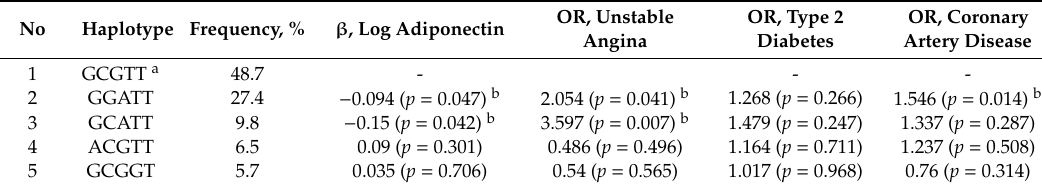
Table 6. Associations of constructed haplotypes with logarithm of serum adiponectin concentration, unstable angina, type 2 diabetes, and coronary artery disease. Haplotypes were constructed using five sequential SNPs of the ADIPOQ gene in the following order: rs17300539, rs266729, rs182052, rs2241766, and rs17366743. A total of five haplotypes with frequency > 5% were